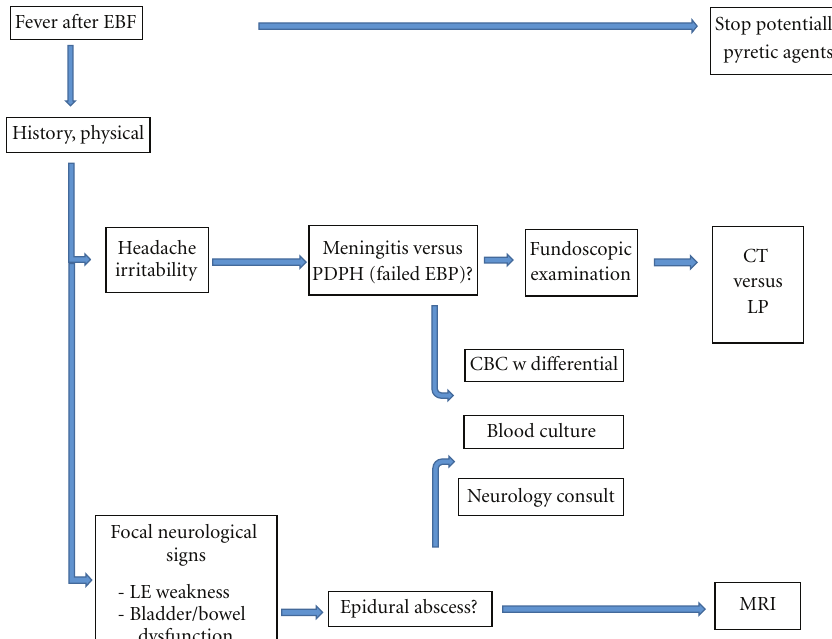
Figure 2: Stepwise diagnostic approach to fever after an